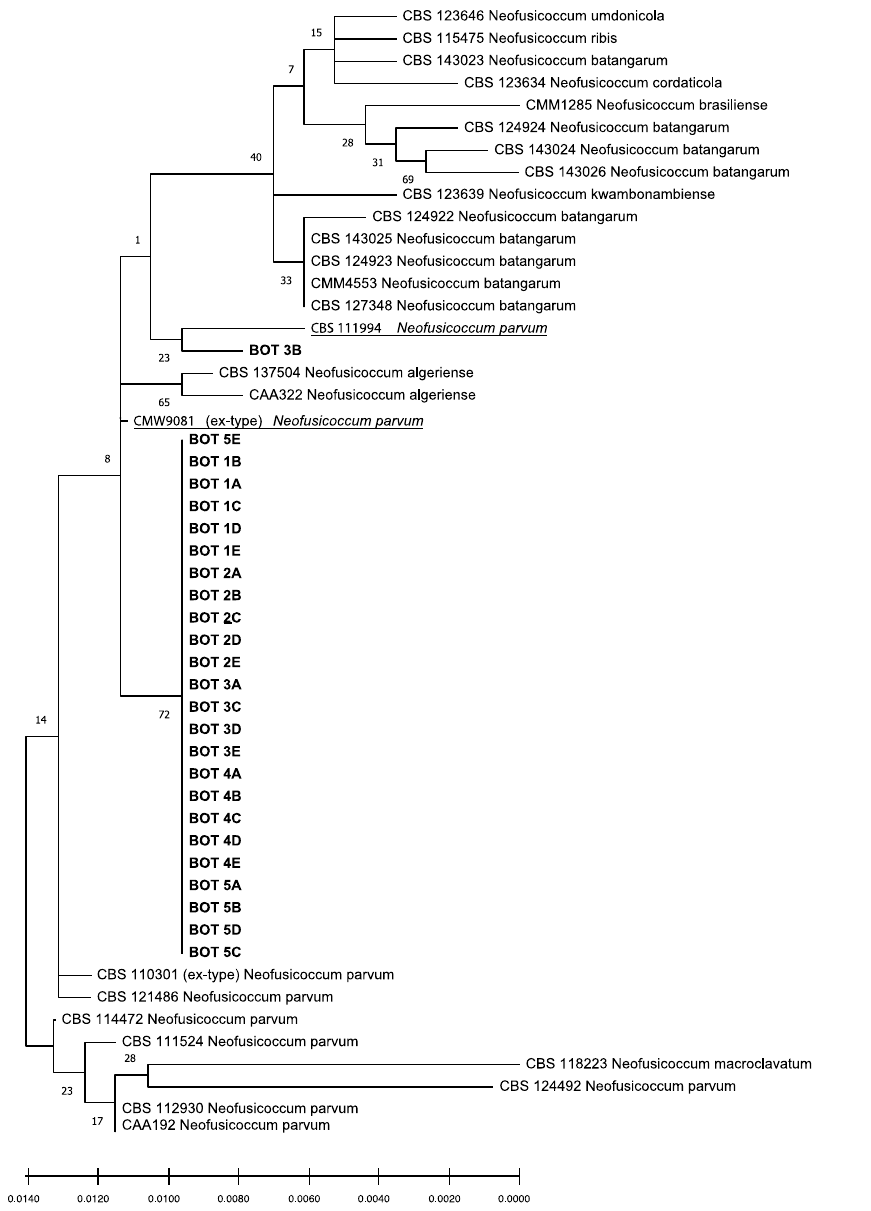
Figure 6. Phylogenetic tree of isolates of Neofusicoccum parvum sourced from lemon trees in this study (in bold), and reference isolates of Neofusicoccum parvum (underlined) and other closely related Neofusicoccum species and isolates (Tables 1 and 2). The tree was built using concatenated sequences of ITS-5.8S-ITS2 region, tef1- α and β -tubulin genes. Numbers on nodes indicate the posterior probabilities from the maximum likelihood